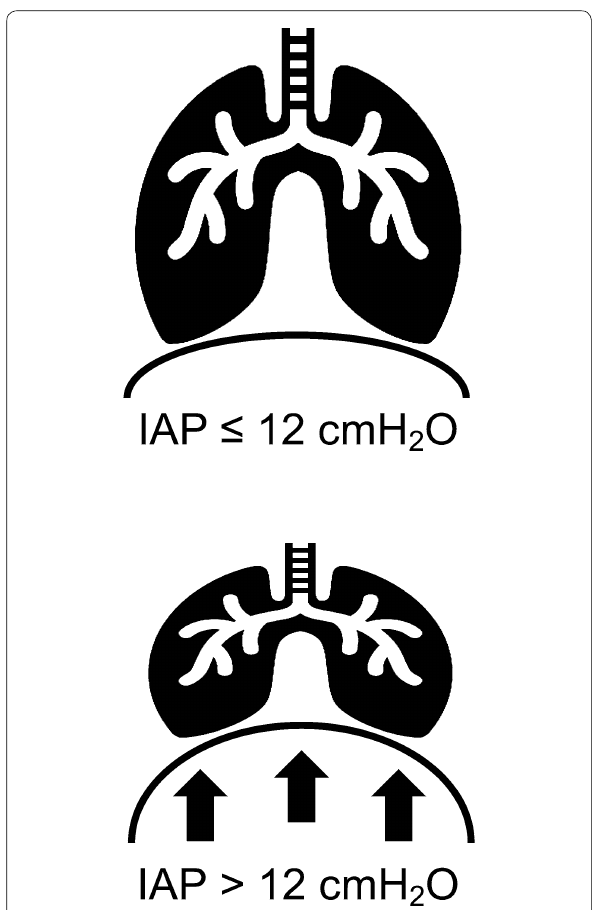
Fig. 2 Effect of intra-abdominal pressure on diaphragmatic dome. IAP intra-abdominal